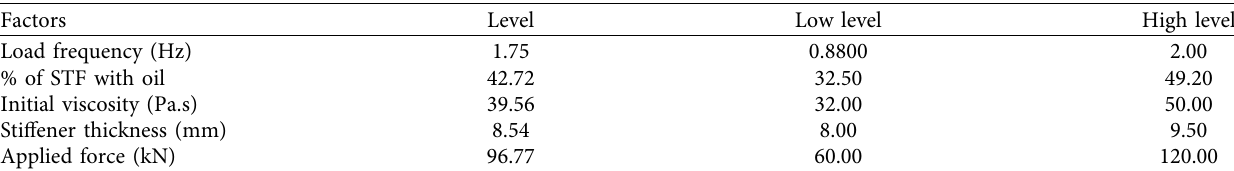
Figure 3: Photographic view of the experimental setup under cyclic loads. Table 1: Process parameters and working range.